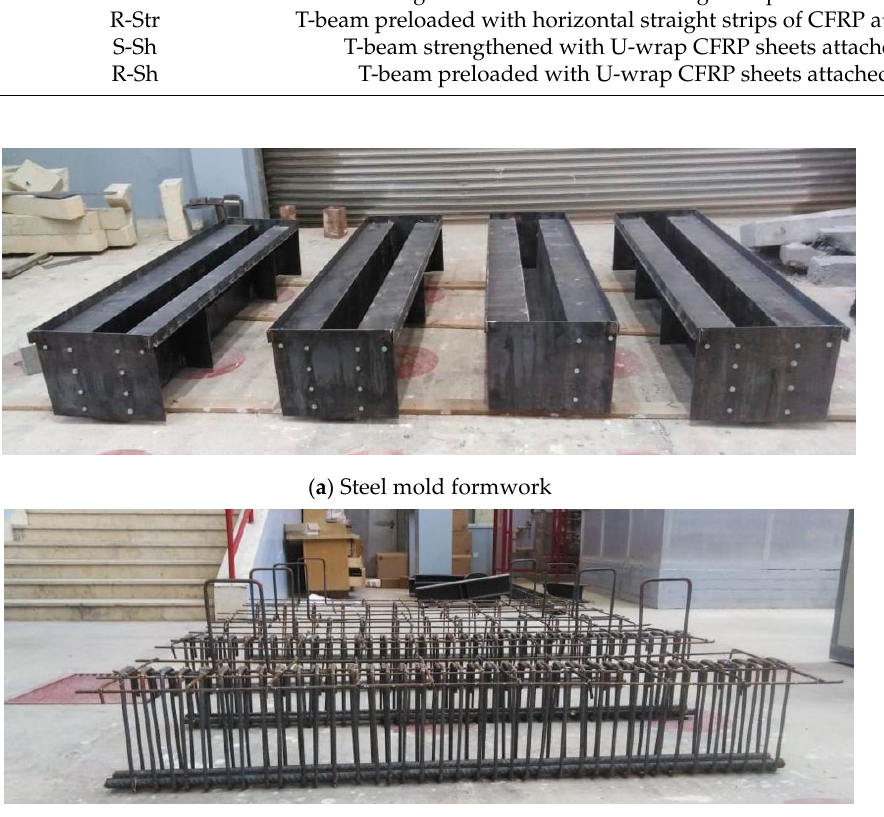
Figure 3. Casting of beams.